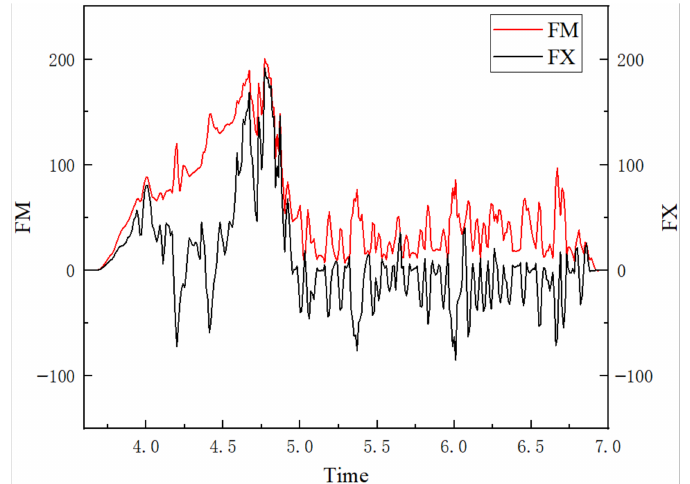
Figure 20. Simulation curve of maximum